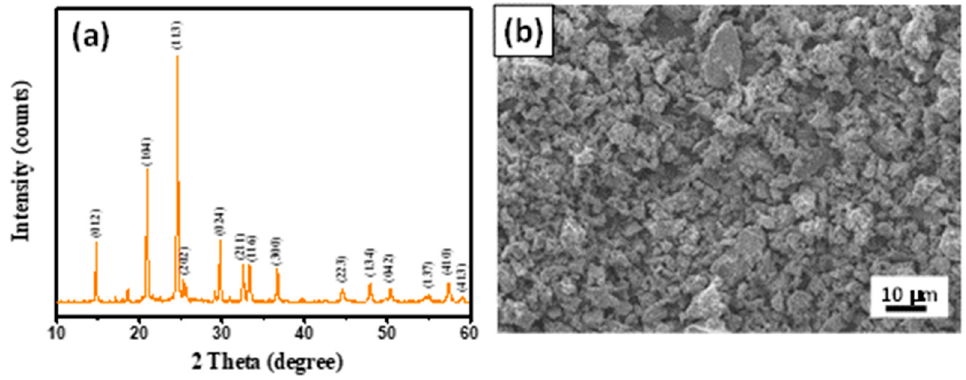
Figure 2. ( a ) Typical XRD pattern and ( b ) FE-SEM image of LATP powders. Th e t ypical XRD pattern of CSEs (i.e., composition: LATP plus LiTFSI plus